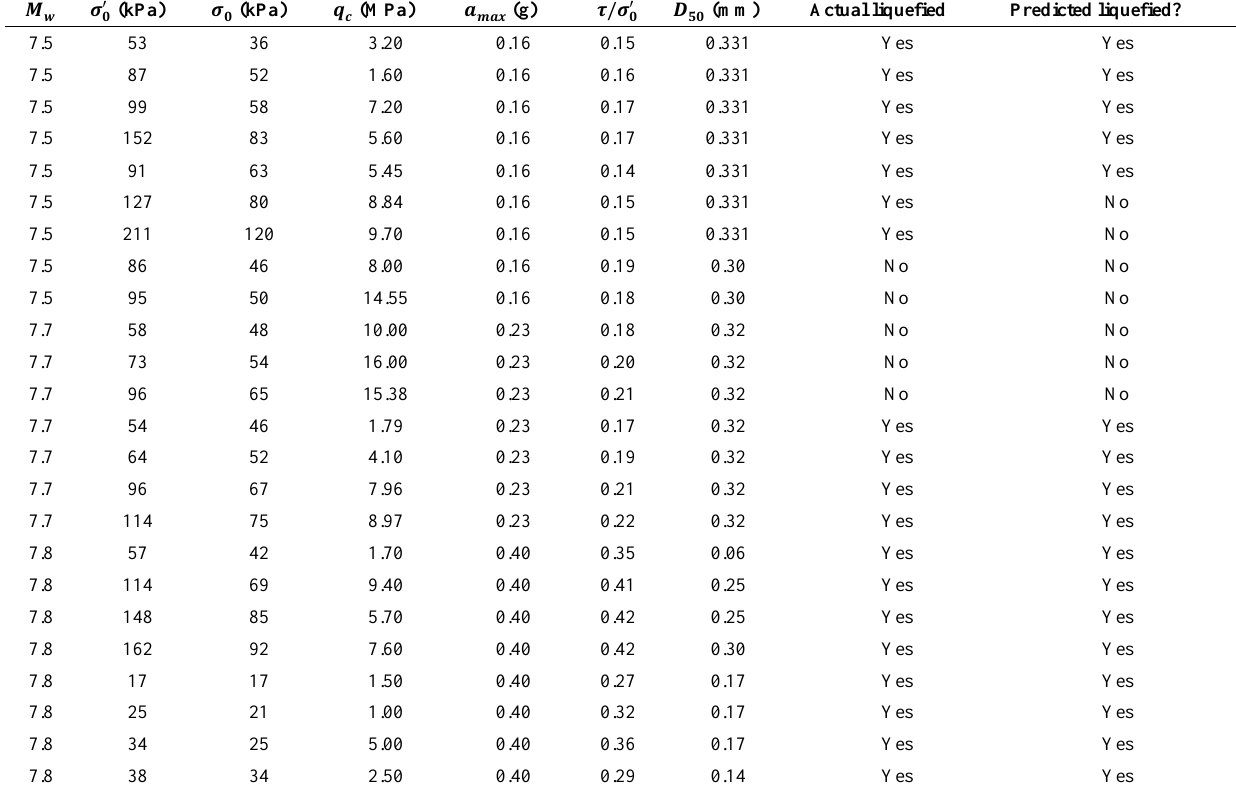
Table 2. Performance of C4.5 for training